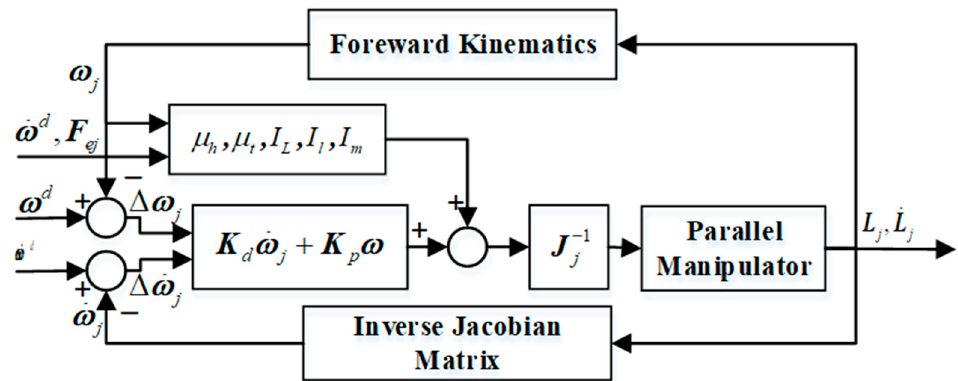
Figure 9. Block diagram of the augmented PD controller.